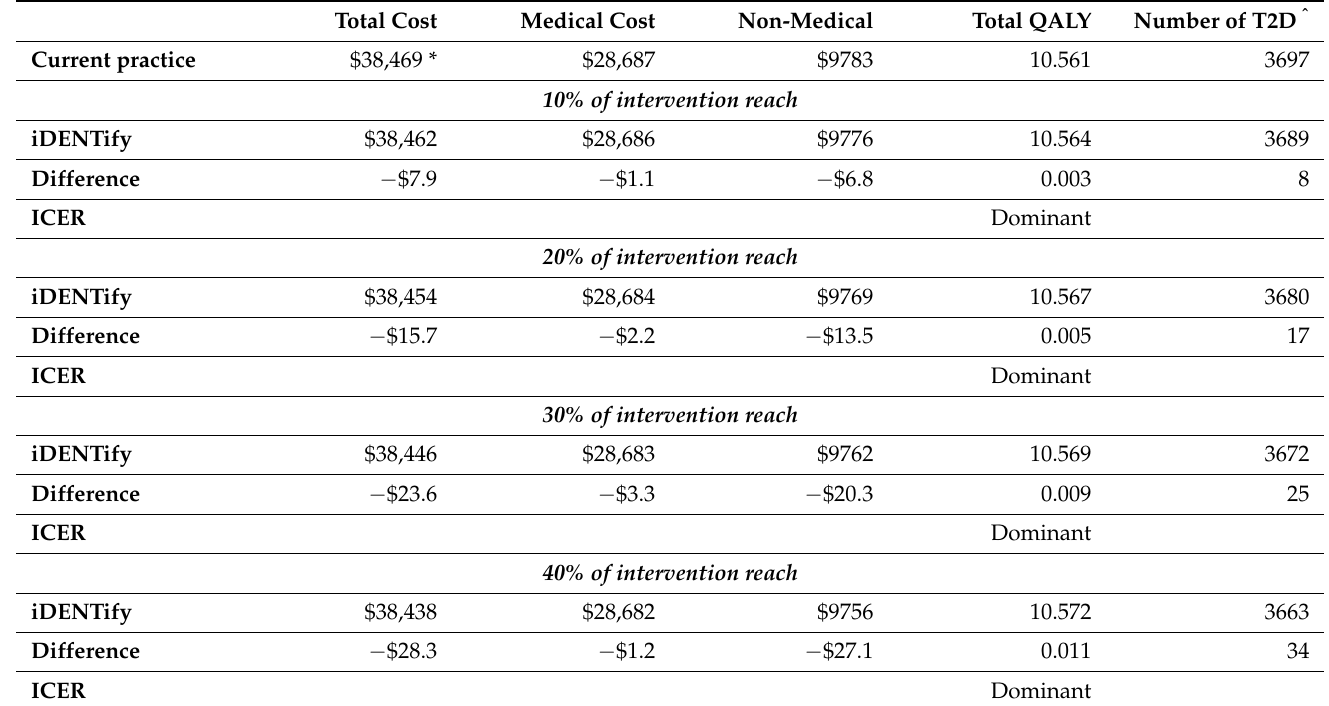
Table 3. Results of base case cost-effectiveness